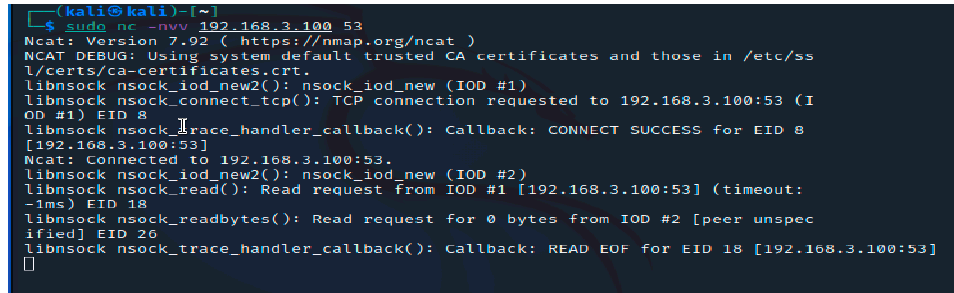
Figure 5. Traceroute result.